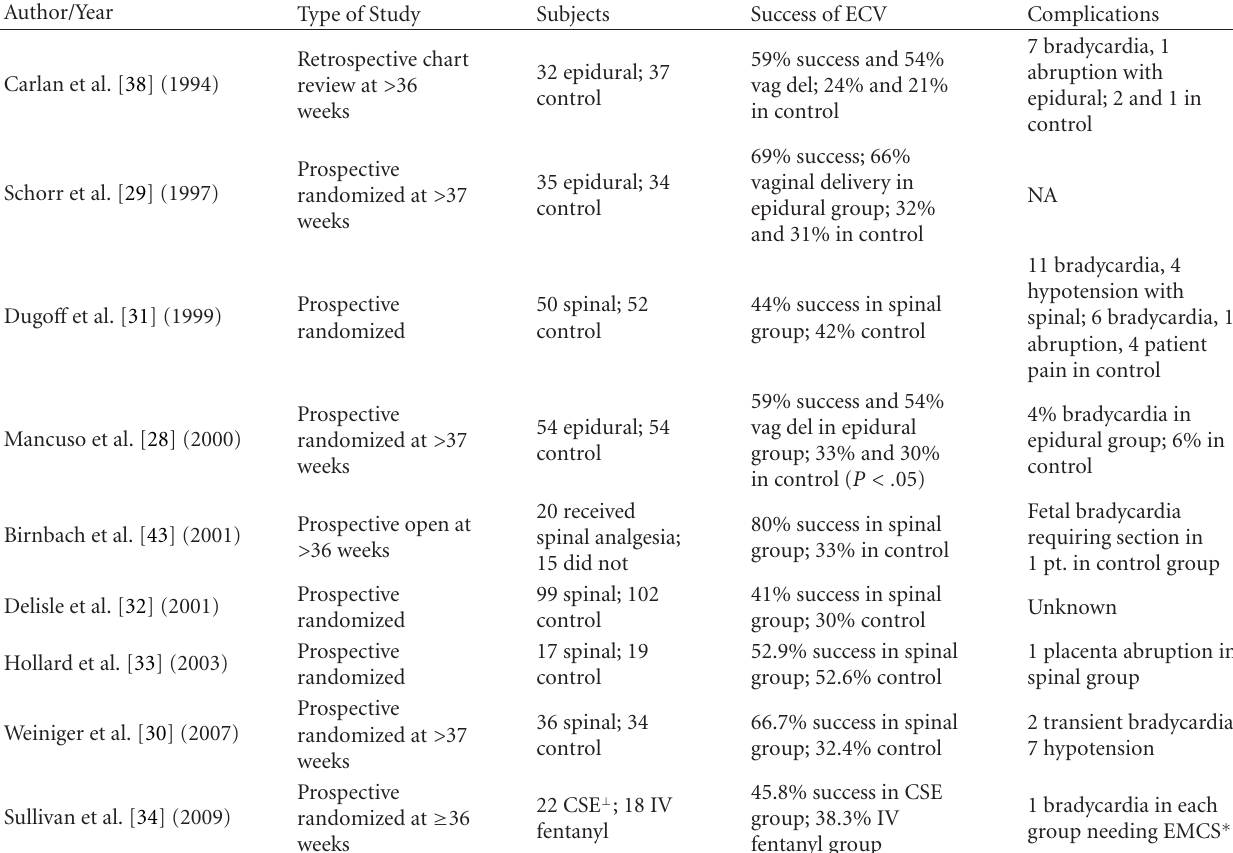
Table 3: Summary of Central Neuraxial Blockade-Assisted ECV Trials.